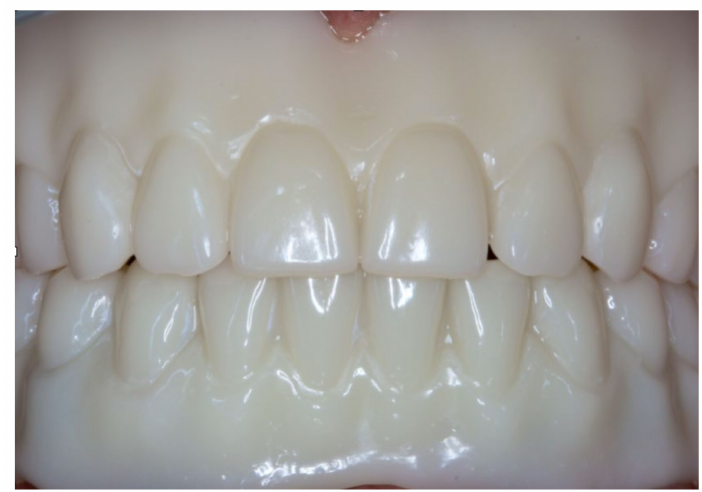
Figure 13. Anterior view of the try-in dentures in the upper and lower jaw during try-in.